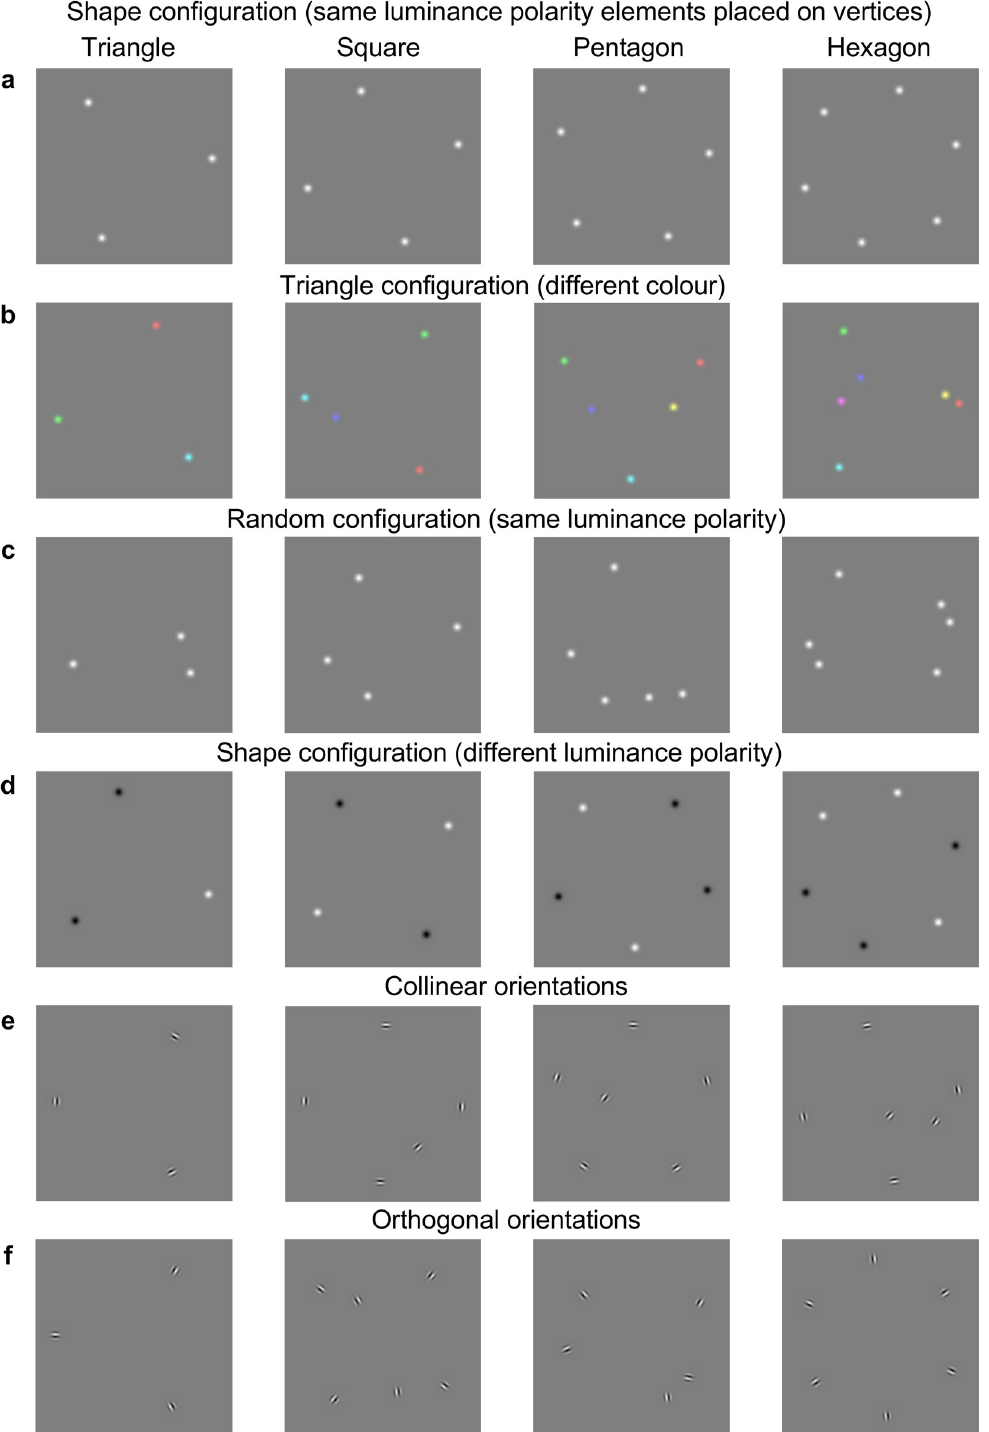
Fig 1. Example stimuli used in Experiments 1–3. Stimuli consisted of a small number of elements (3, 4, 5 or 6) positioned either (a) on the vertices of simple shapes, e.g., equilateral triangle, square, pentagon and hexagon or (c) random, e.g., elements placed randomly anywhere within and including the virtual contour-path except on the vertices. (b) Equilateral triangle sampled by either 3, 4, 5 or 6 elements, with three elements always positioned on the vertices and the remaining elements placed randomly anywhere within and including the virtual contour-path. (d) Stimuli made of